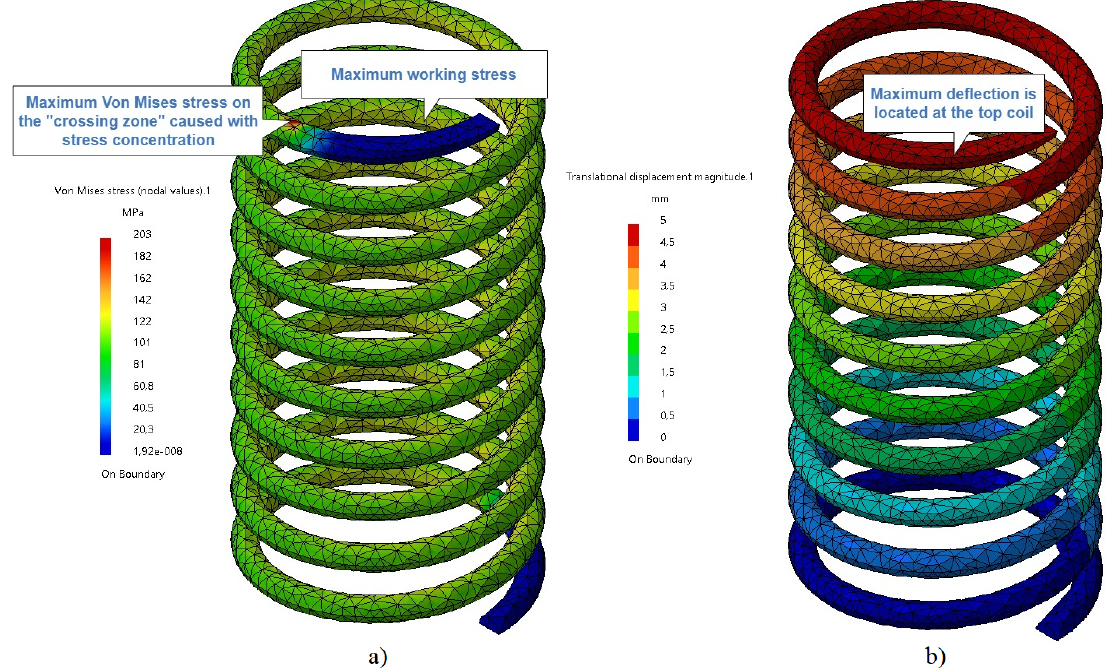
Figure 7. Compression spring with plain ends FEM analysis results. ( a ): Von Mises tress, ( b ): Dis- placement.